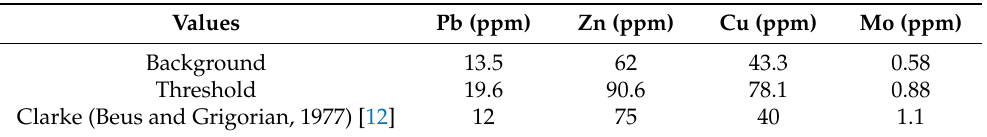
Table 1. Background, threshold, and Clarke values for supra-ore (Pb and Zn) and sub-ore (Cu and Mo) elements in the study